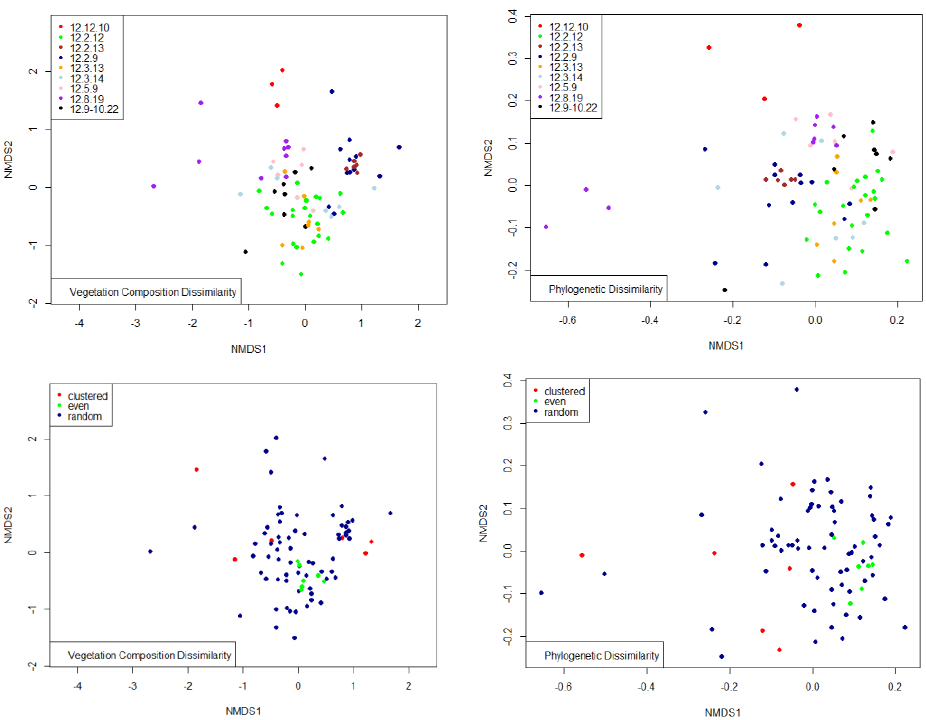
Figure 4. Comparison of non-metric multidimensional scaling (NMDS) analyses for comparing relationships among 80 Sunshine Coast heathland sites. Vegetation composition using Bray–Curtis dissimilarity is shown on the ( left ) and phylogenetic Unifrac dissimilarity is on the ( right ). Sites have been coloured by their regional ecosystems ( above ) and by their NRI significance ( below ).